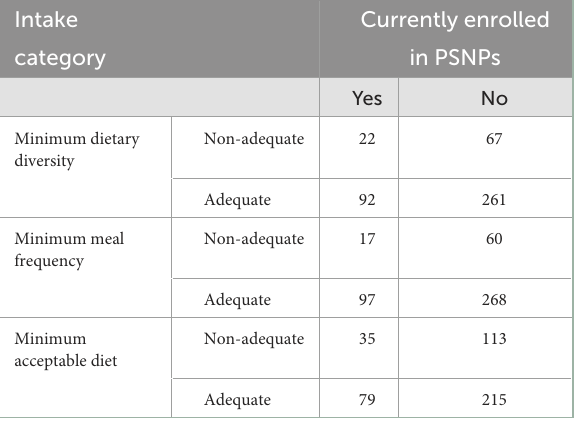
TABLE 4 Children’s practice of the minimum acceptable dietary intake parameter with Productive SafetyNet enrolment status in the South Gondar Zone, Northwest Ethiopia, 2017 ( n =